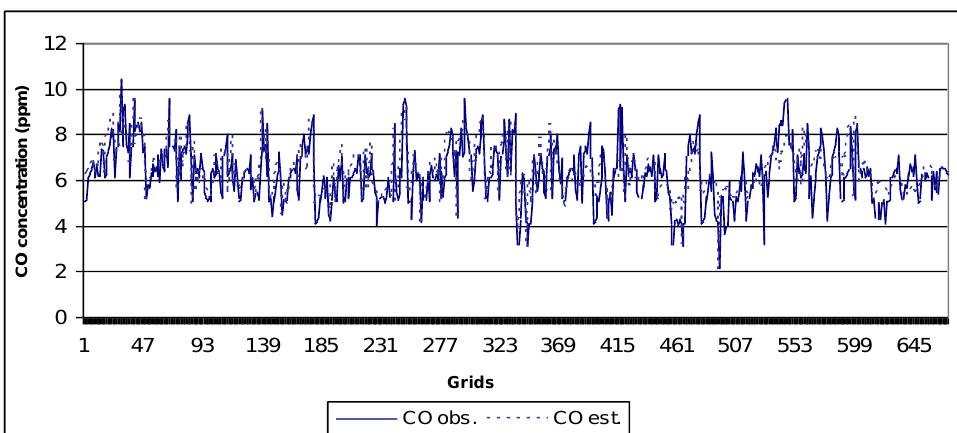
observed and estimated monthly average in the GTA 2